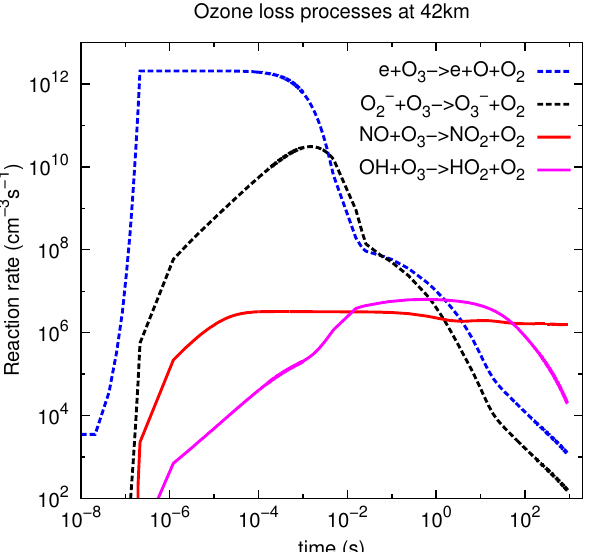
Fig. 7. The four most important ozone loss reactions in a daytime sprite streamer at 42 km. Shown are the two main (dotted) ionic and (solid) neutral processes, respectively.